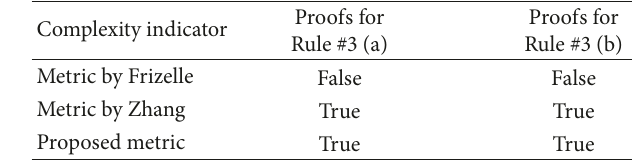
Table 9: Proofs of Rule